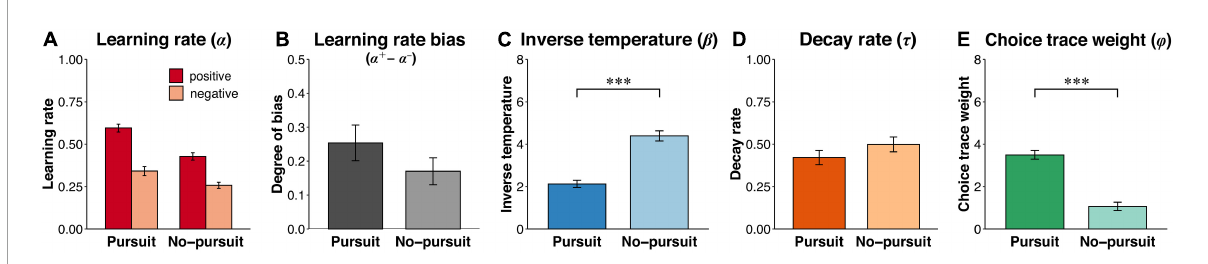
FIGURE5 Estimated parameters with the hybrid model. The figure shows the estimated parameters by fitting the hybrid model to the choice data derived from the online experiment. (A) The learning rates for the positive and negative reward prediction errors ( α + and α − ). (B) The learning rate bias calculated by subtracting the negative learning rate from the positive learning rate ( α + – α − ), indicating the degree of asymmetric value updating. (C) The inverse temperature ( β ) representing the sensitivity to value differences in decision-making. (D) The decay rate ( τ ) indicating how far past choices are incorporated into the next choice. (E) The weight of choice history ( ϕ ) representing the sensitivity to differences in the choice history in decision-making. Error bars represent the standard error of the mean. Asterisks denote significant group differences: ∗∗∗ p < 0.001 and ∗∗ p <